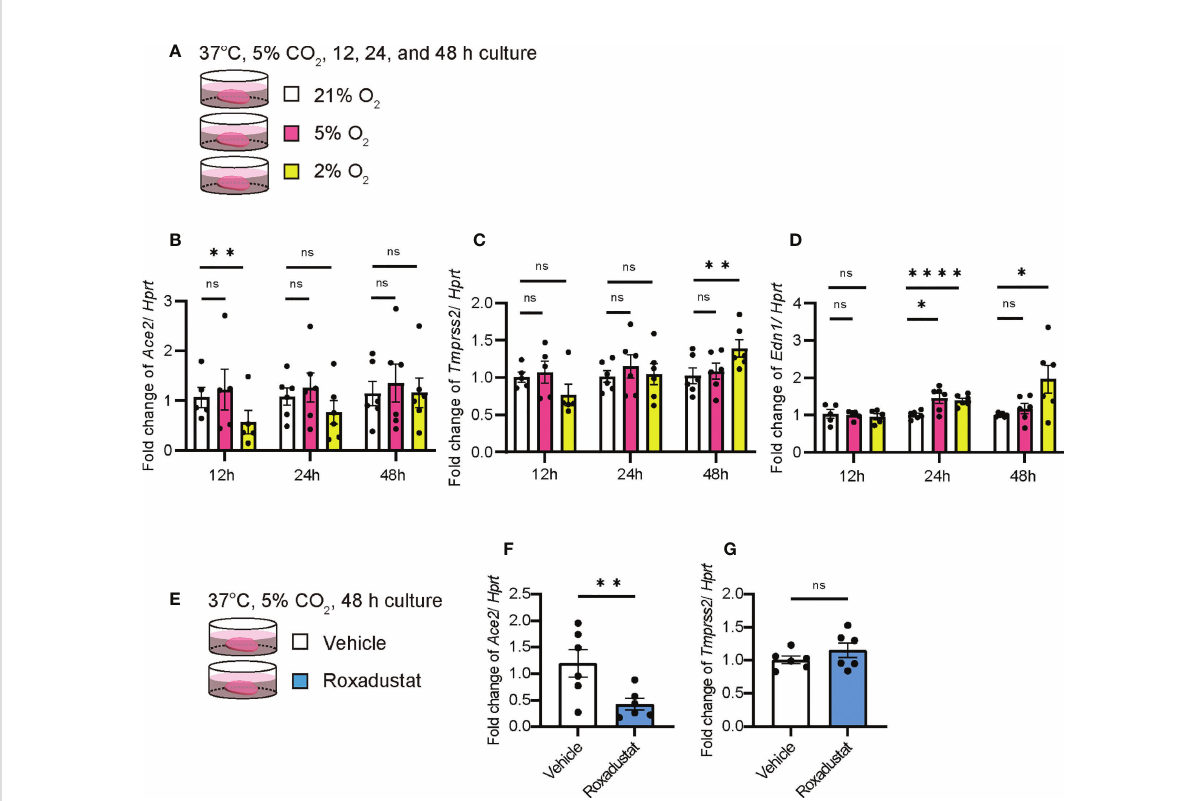
FIGURE 6 Hypoxia decreased Ace2 expression qPCRs using ex vivo culture of PCLS at week 0 under hypoxia were performed. (A) Schematic diagram of protocol in PCLS under normoxia (21%), physioxia (5%), and hypoxia (2%). (B – D) Fold changes in the expression levels of each gene, Ace2 (B) , Tmprss2 (C) , and Edn1 (D) . (E) Schematic diagram of the protocol using roxadustat, which is an HIF- a prolyl hydroxylase inhibitor, under normoxia in PCLS. (F – G) Fold changes in the expression levels of Ace2 (F) and Tmprss2 (G) . Hprt expression was used as an internal control for qPCR. Each bar represents vehicle (white bars) and roxadustat (blue bars). Each mRNA was prepared from the PCLS samples after 12, 24, and 48 h of treatment. Data are presented as mean ± SE of fi ve to six mice. Asterisks indicate * P < 0.05, ** P < 0.01, and **** P < 0.0001 compared with week 0. “ ns ” is not statistically signi fi